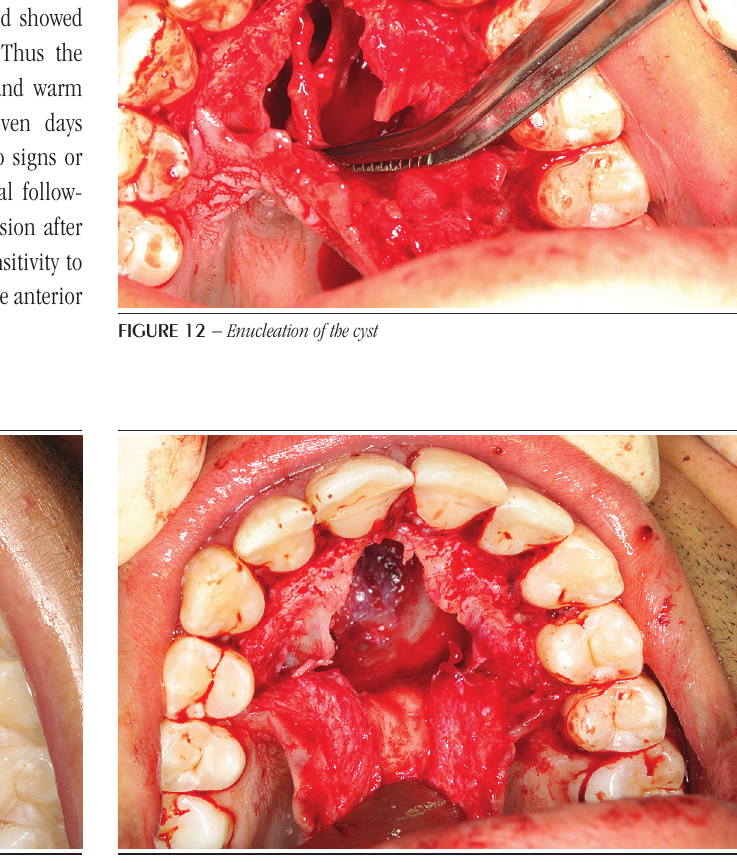
figurE 13 − Surgical cavity